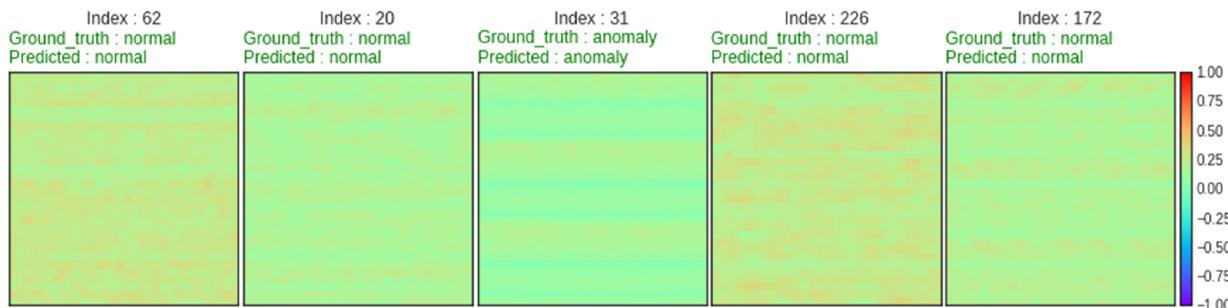
Figure 7. Slide rail data (16 K) Hilbert transform image encoding.